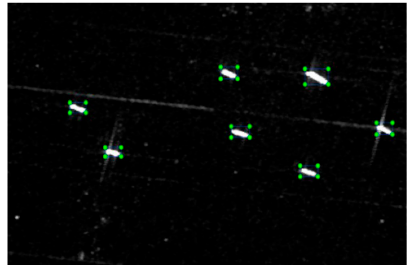
Figure 4. Sample labeling of ship using LabelImg software.